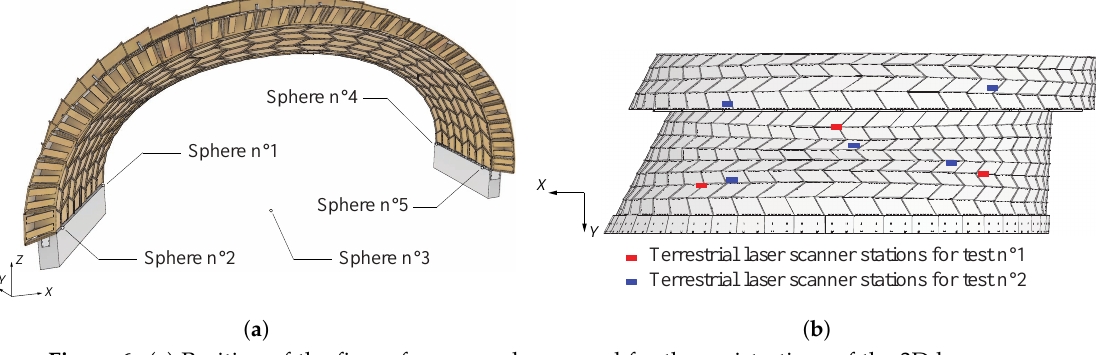
Figure 6. ( a ) Position of the five references spheres used for the registrations of the 3D laser scans; ( b ) Position of the stations of the 3D laser scans for test n° 1 (red) and test n° 2 (blue).